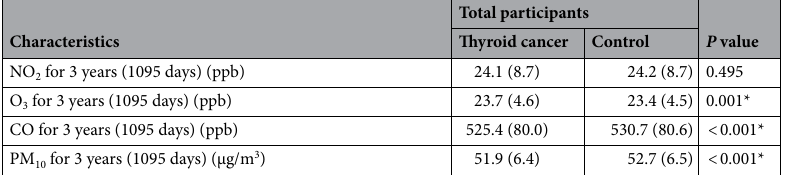
Table 1. General characteristics of participants. BMI body mass index (kg/m 2 ); ppb parts per billion; SD standard deviation. *Chi-square test or independent t test. Significance at P < 0.05.